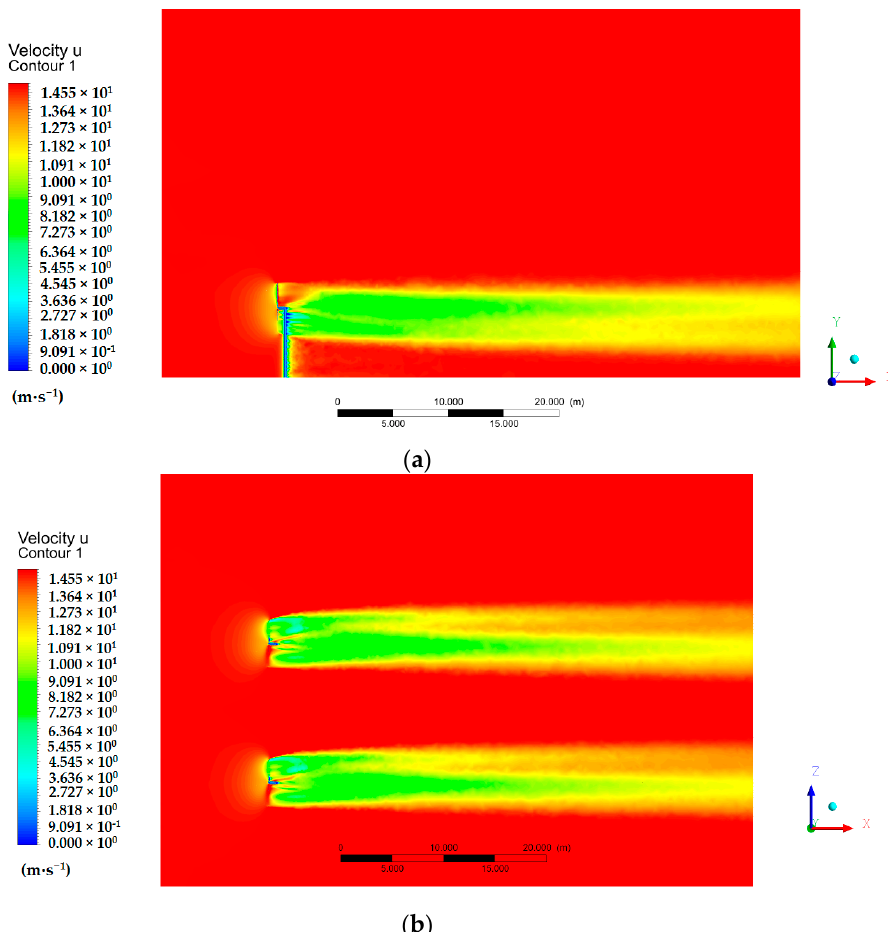
Figure 3. Axial time-averaged velocity contours for the two-turbine case, representing the first row of wind turbines. ( a ) Lateral view of the wake; and ( b ) top view of the wake. wind turbines. ( a ) Lateral view of the wake; and ( b ) top view of the